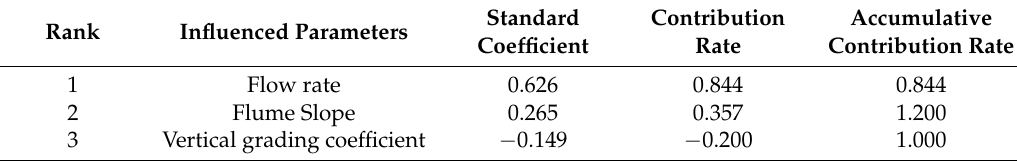
Table 4. Contribution rates of experimental factors on Froude